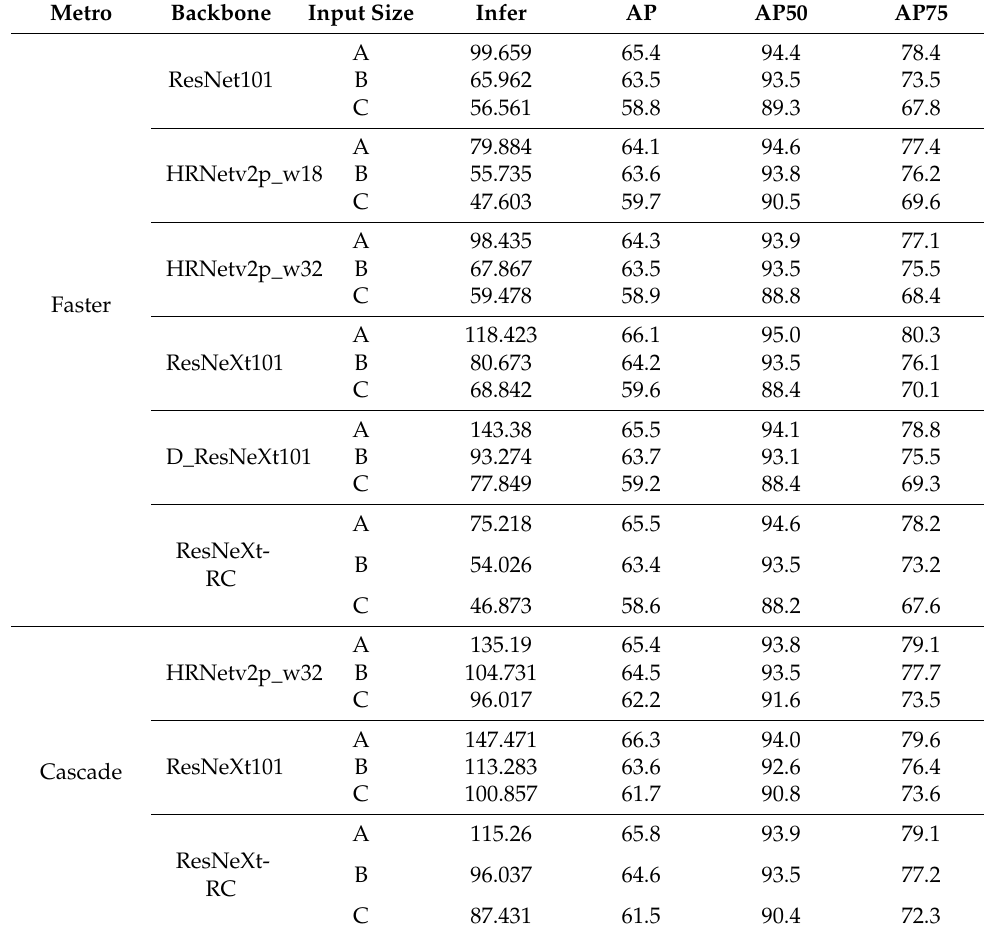
Table 2. Analysis of inference performance of different scales based on nine